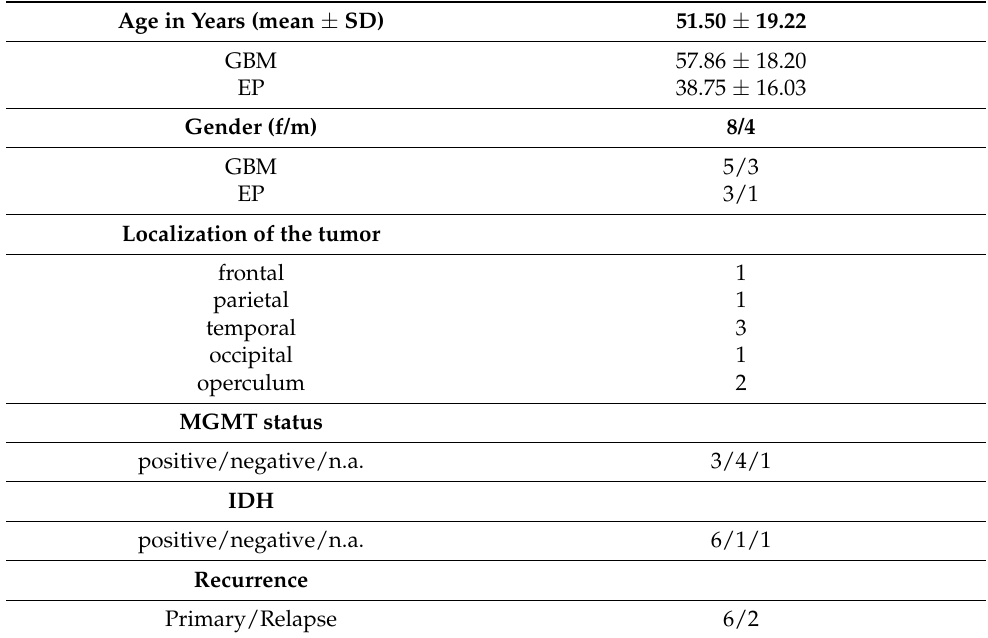
Table 1. Patients’